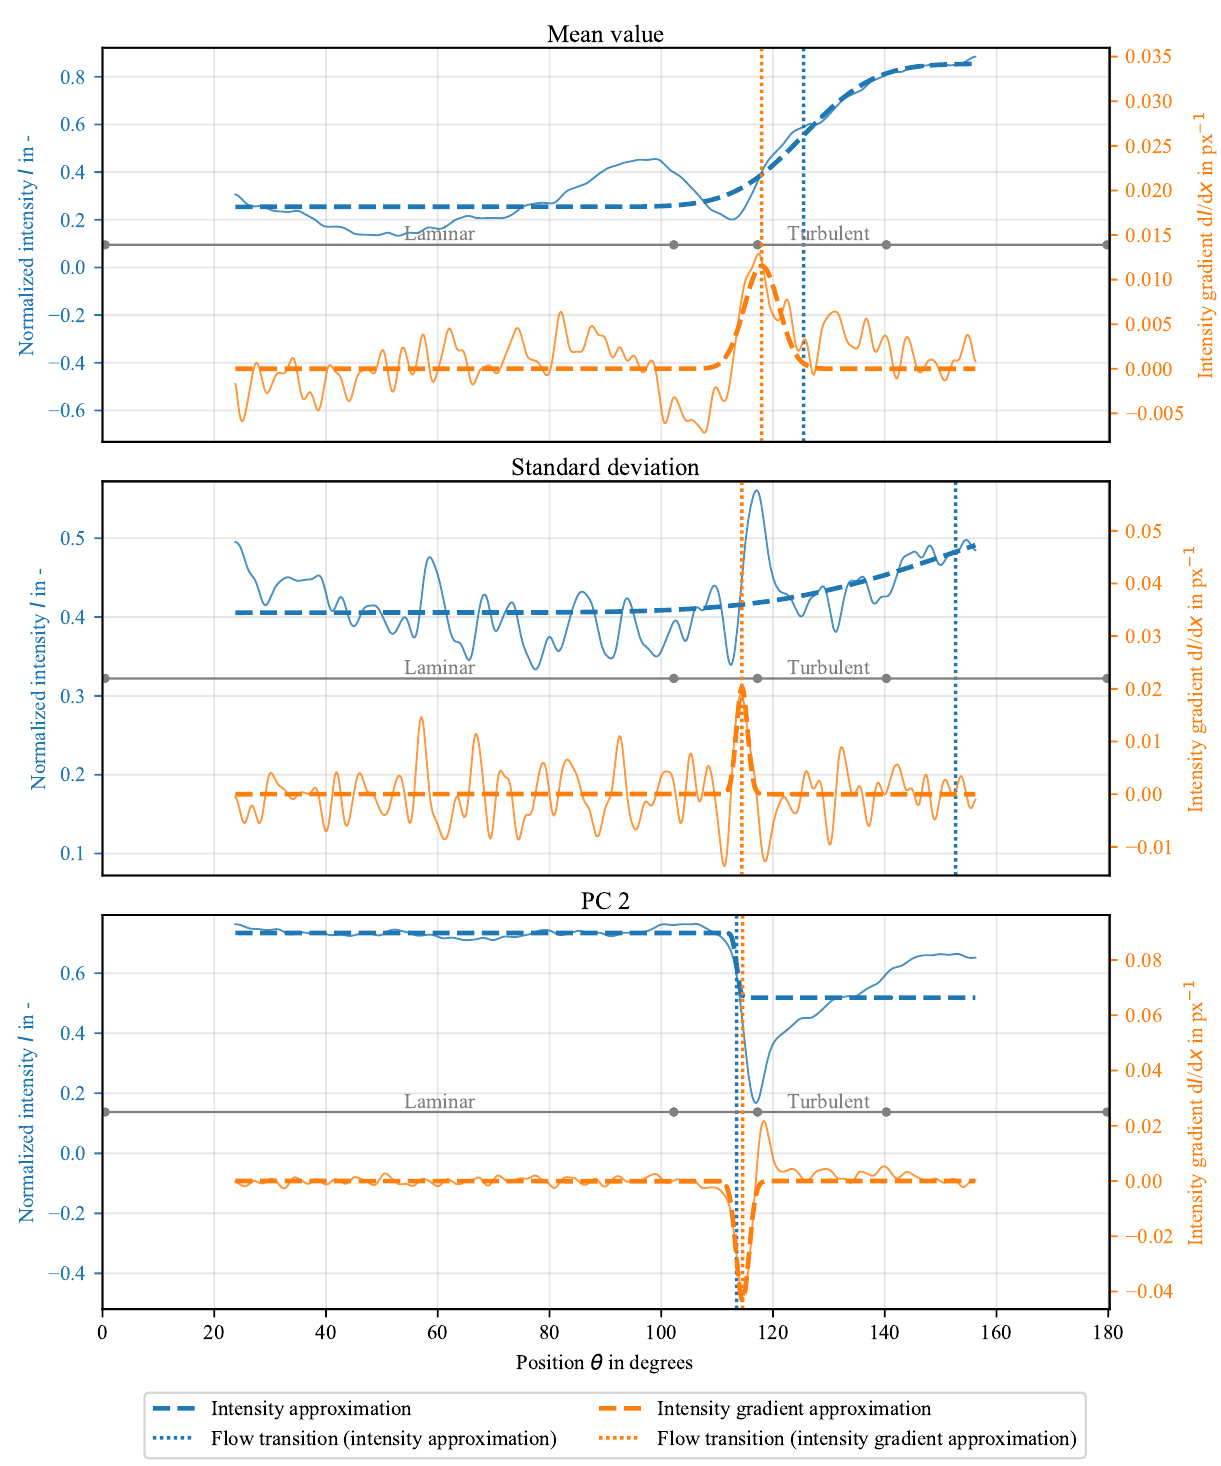
Figure 6. The intensity profile (blue line), intensity gradient profile (orange line) along the white dotted line in the temporal mean value, temporal standard deviation and PC 2 flow visualization in Figure 5. The approximation of the intensity profile (blue dashed) and intensity gradient profile (orange dashed), respectively. The flow transition localization results of both methods are depicted with a vertical dotted line in the respective color. Different expressions of the intensity plateaus are visible in each profile with varying gradient amplitudes between the plateaus. The most distinct expression of two plateaus including a steep step between them exists in the PC